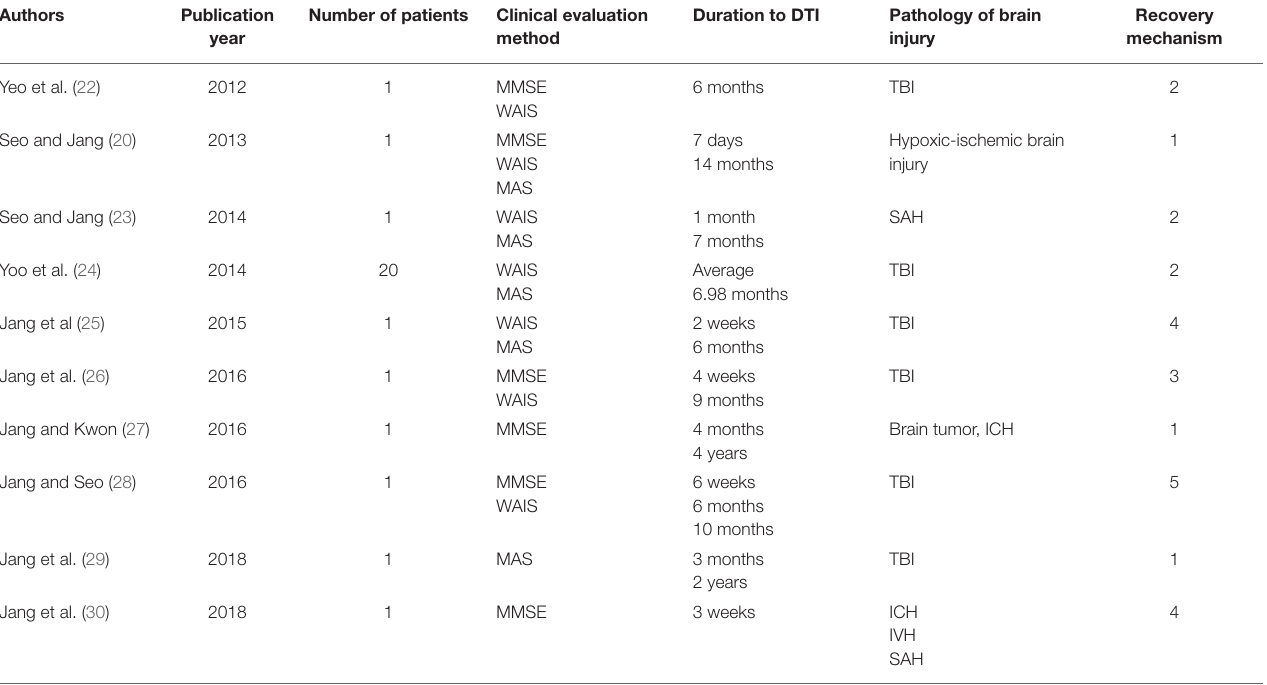
TABLE 1 | Previous diffusion tensor imaging studies on the recovery mechanisms of injured cinguli.